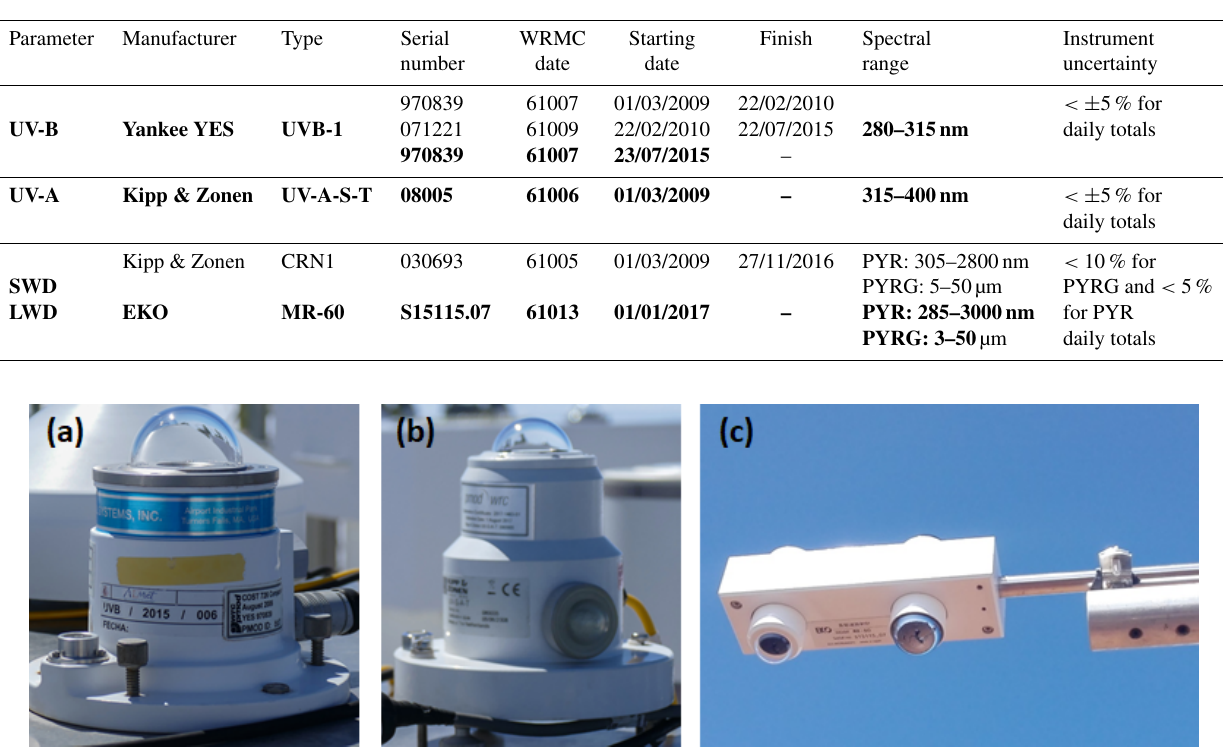
Table 2. Extended-BSRN radiation instruments installed between 2009 and 2017 at IZA BSRN (UV-B, UV-A, SWD and LWU). Same as Table 1.